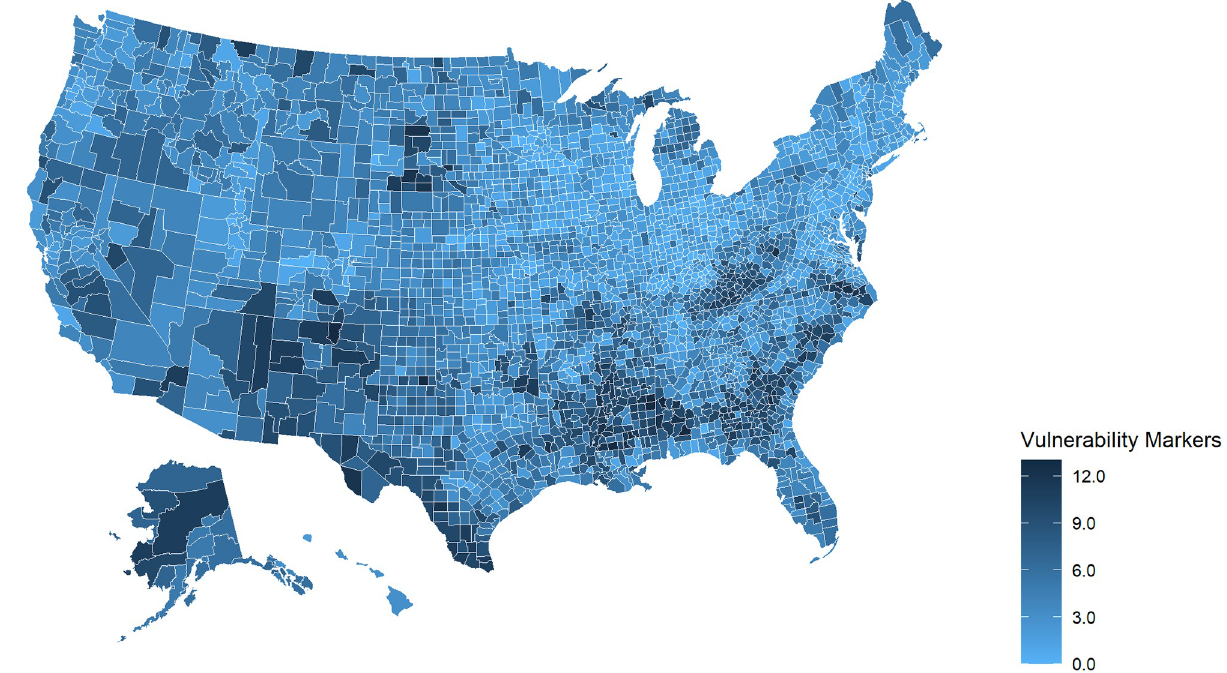
Fig 1. Markers of medical, economic, and geographic vulnerability in the United States, 2017. Map prepared using R’s open source package, usmaps, developed by Paolo Di Lorenzo under a GNU General Public License (GPL), Version 3 (https://cran.r-project.org/package=usmap).